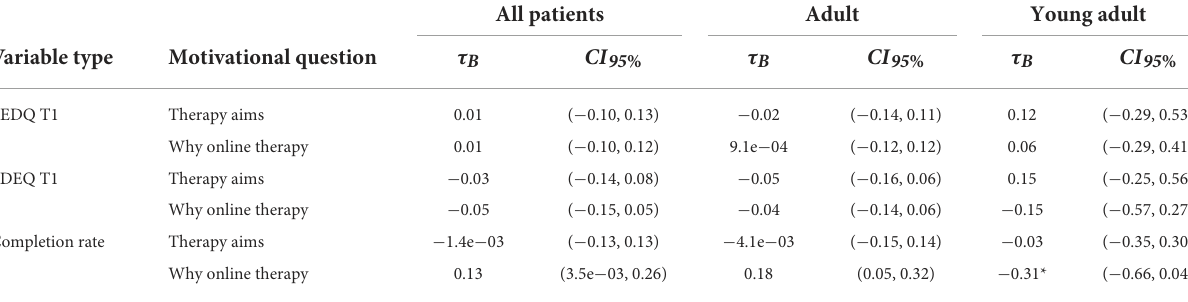
TABLE 7 Correlations between seq13ntiment score and treatment outcome, by variable type and motivational question. All patients